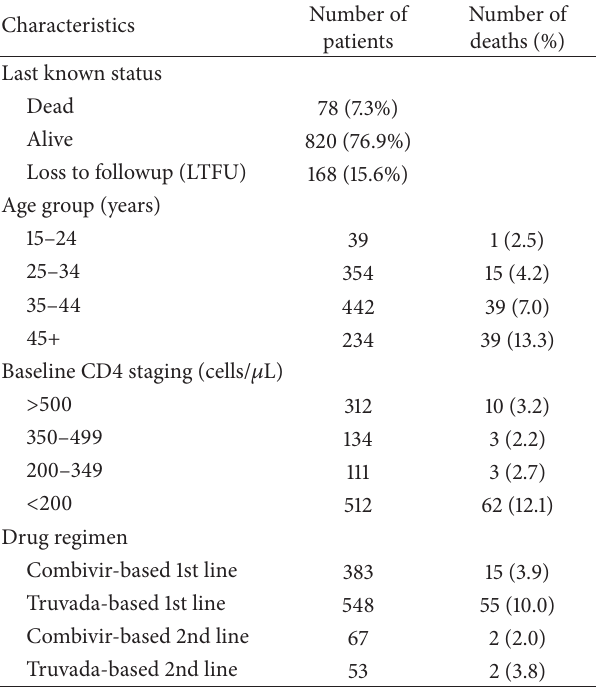
Table 2: Baseline characteristics and associated mortality among 1069 PLWHA in Nigerian Christian Hospital.